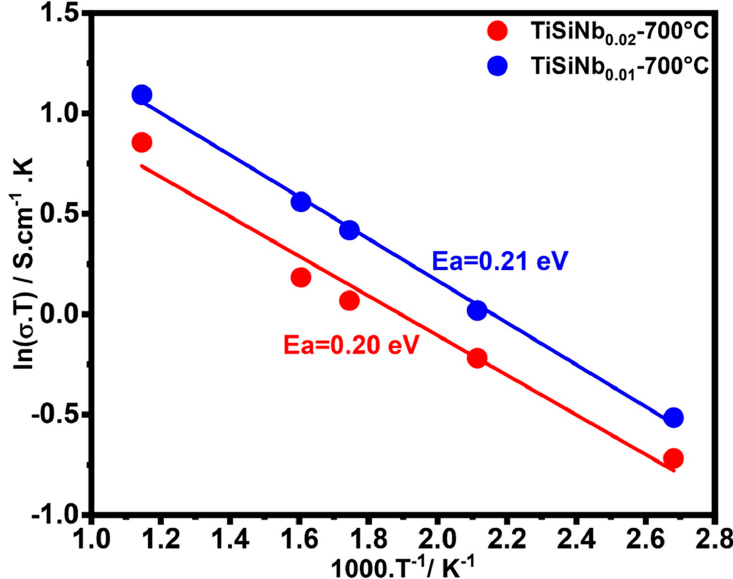
Figure 10. Arrhenius-plot of TiSNb with different Nb content annealed at 700 °C in N 2